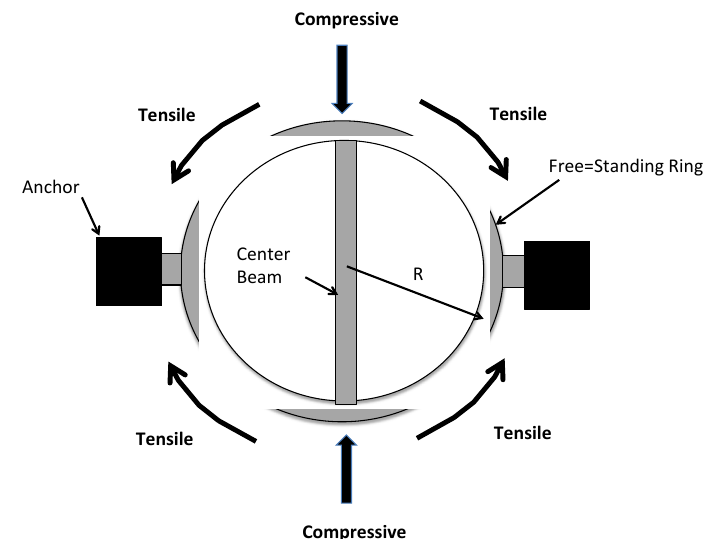
Figure 8. A Guckel ring residual stress test structure.